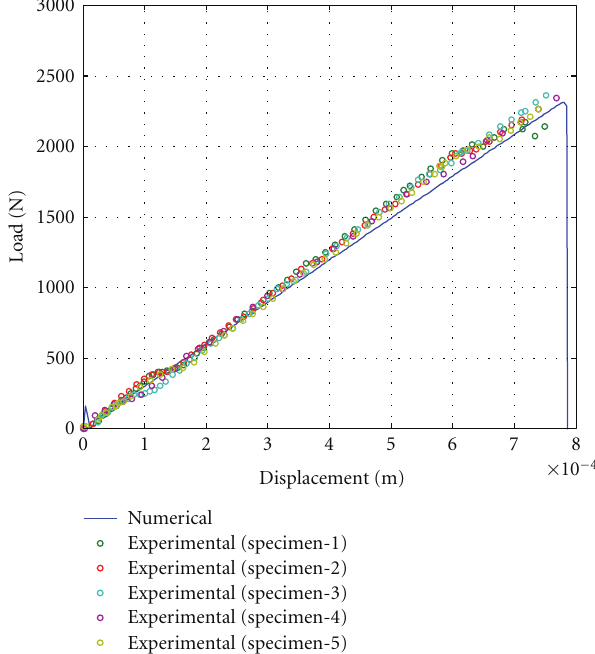
Figure 19: Comparison between numerical predictions and experimental results for the matrix tensile tests. in the experiments. The prediction of the failure location direction is a shear dominated failure mode with a fracture for transverse compression, Figure 25, correlate very well plane orientated about 50 0 in respect to the through the thickness direction. In order to avoid element with the experiments indicating that the failure in transverse